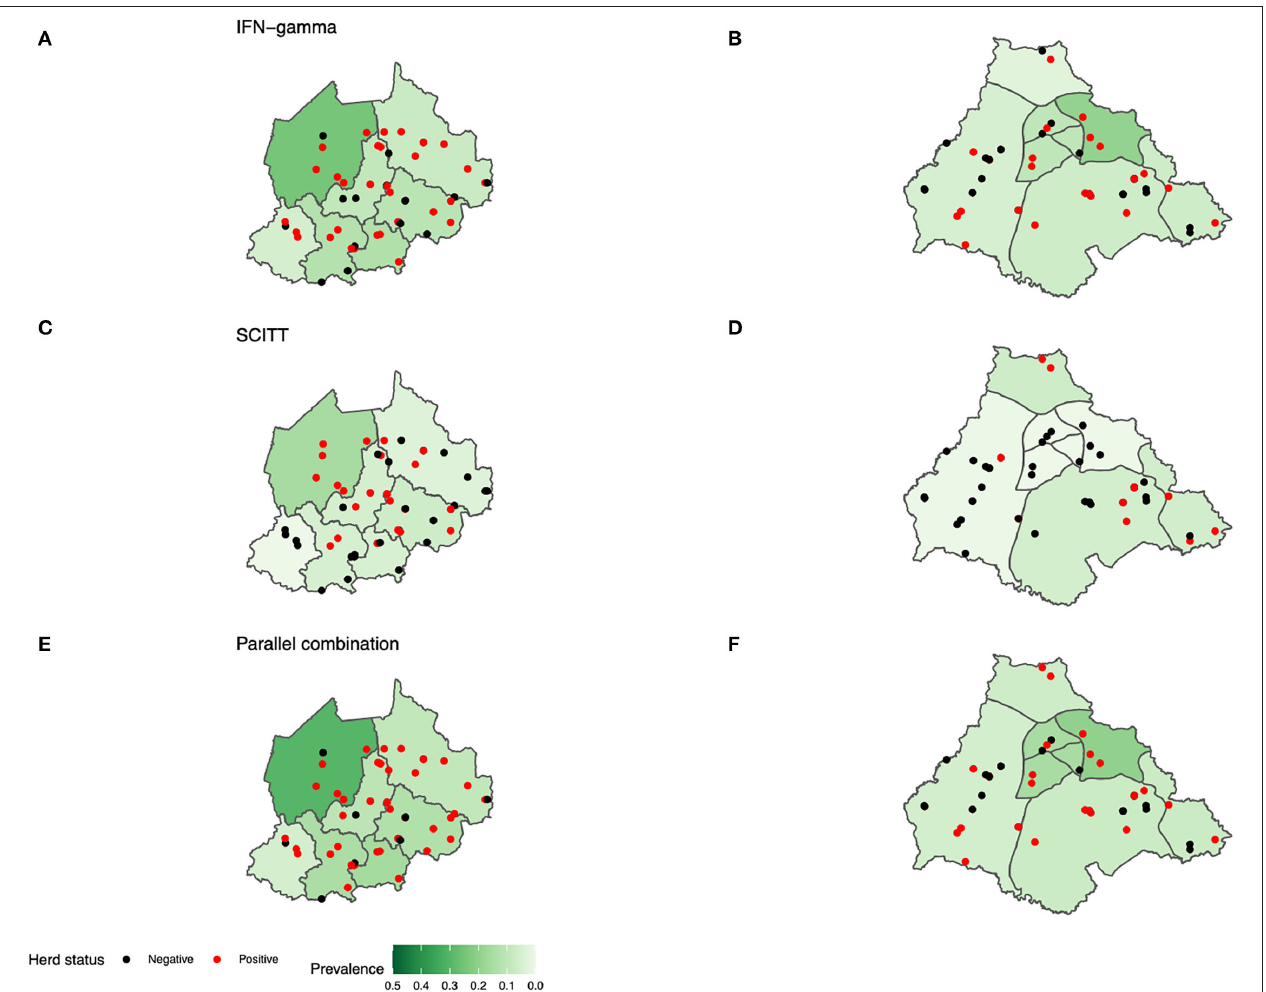
FIGURE 5 | Map study site by sublocation prevalence for pastoral cattle. (A,B) IFN- γ assay ( ≥ 0.1), (C,D) SCITT ( > 2mm) and (E,F) Parallel combination [subfigure (A,C,E) NWR n = 750. (B) VIN n = 748. (D,F) VIN n = 741]. Positive herds have at least one infected animal per